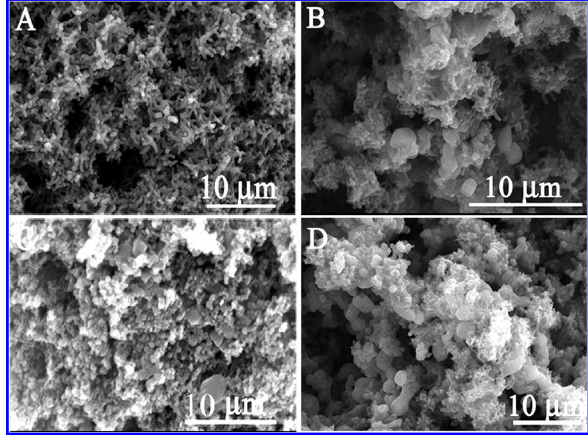
Figure 8: SEM images of (A) PANI-CC, (B) PANI-CNT@ZIF-67-CC, (C) ZIF-67-CC and (D)